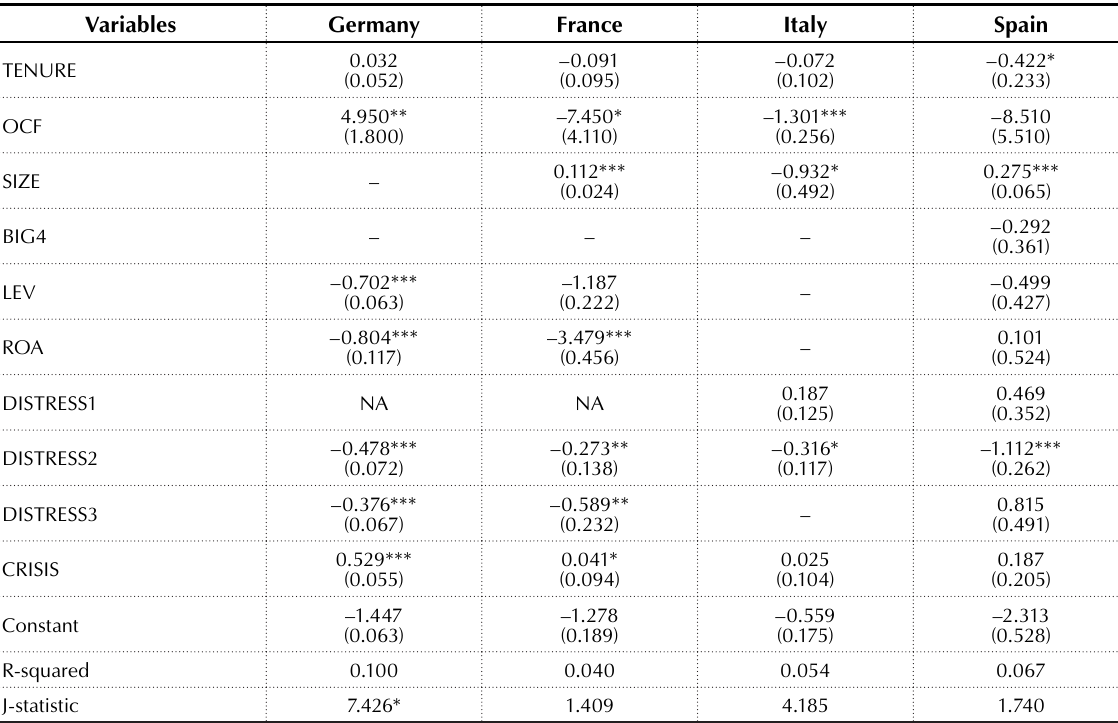
Table 4. GMM robustness results for Germany, France, Italy and